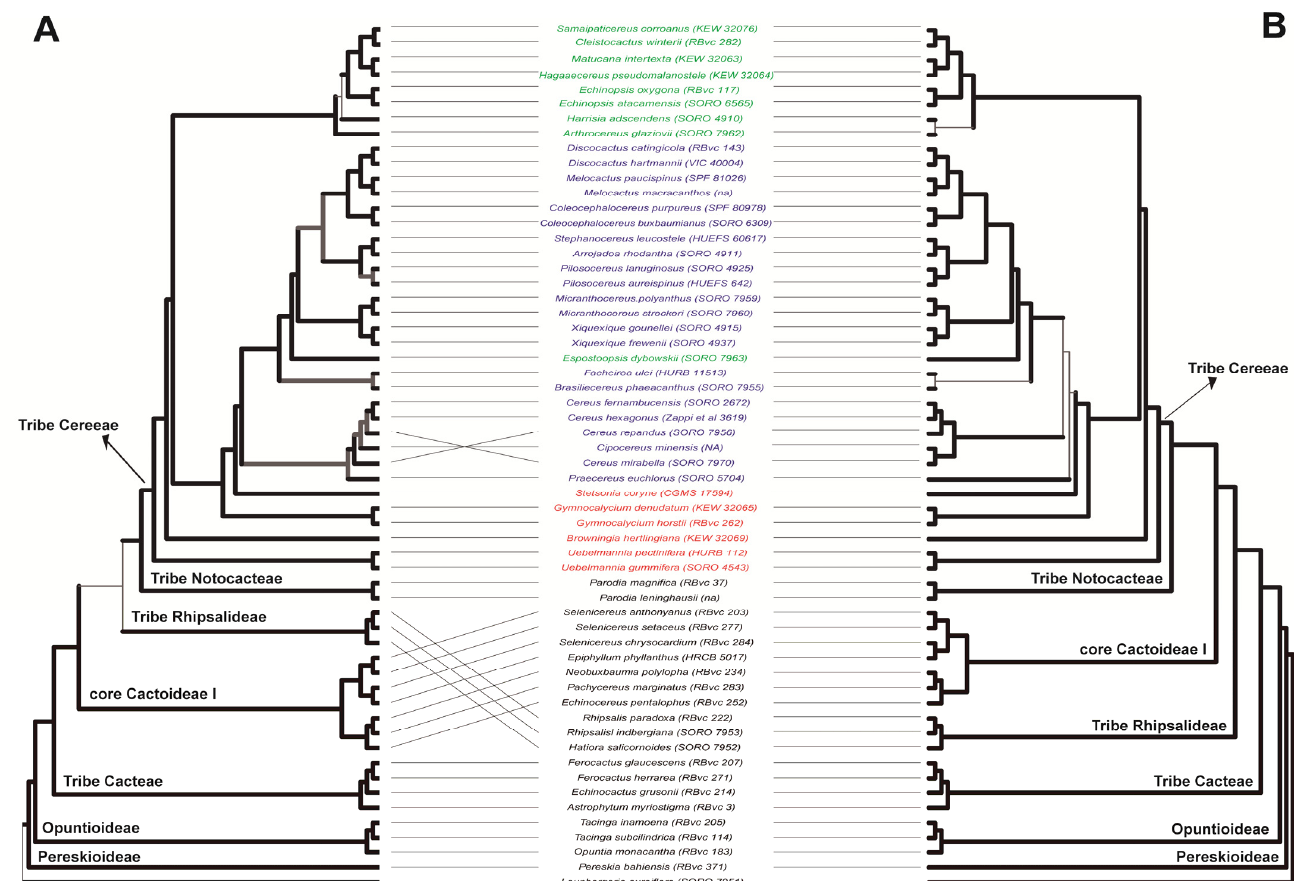
Figure 1. Comparison of coalescent-based species trees of Cactaceae estimated with Cactaceae-coding ( A ) and Cactaceae-all ( B ) sub-datasets. Cactaceae-coding and Cactaceae-all sub-datasets included 290 and 512 nuclear regions, respectively. The branches with high support (LPP > 0.95) are colored with thick dark lines, the branches with moderate support (LPP 0.95–0.70) are colored with thick gray lines, and the branches with low support (LPP < 0.70) are shown as thin light lines. Voucher number of each accession is provided in parenthesis after species names. Species from the subtribes Rebutinae, Trichocereinae, and Cereinae are colored red, green, and blue, respectively (sensu Nyffeler and Eggli [48]). LPP: local posterior probability.